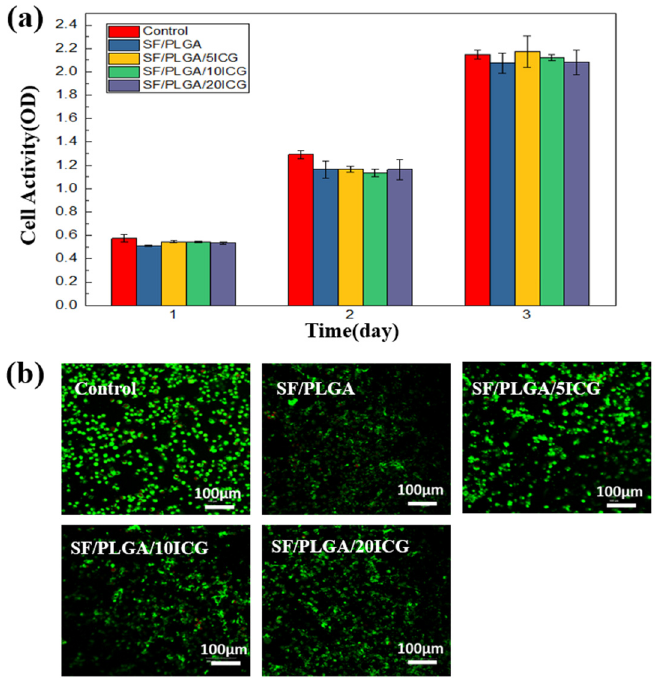
Figure 6. ( a ) Effect of the nanofibrous membranes on L929 cells; ( b ) live and dead cell staining on the third day.